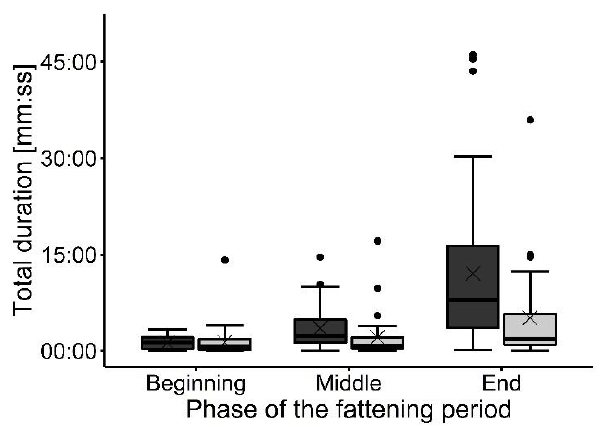
Figure 3. Total time completely observed focal animals ( n = 80) spent in the observed area compared to runaways ( n = 100) at the different phases of the fattening period. Results are presented as boxplots (data range, median, and lower and upper quartile; outliers are included in the graph as dots and means as a cross). Completely observed animals are presented in dark gray; runaways in light gray.